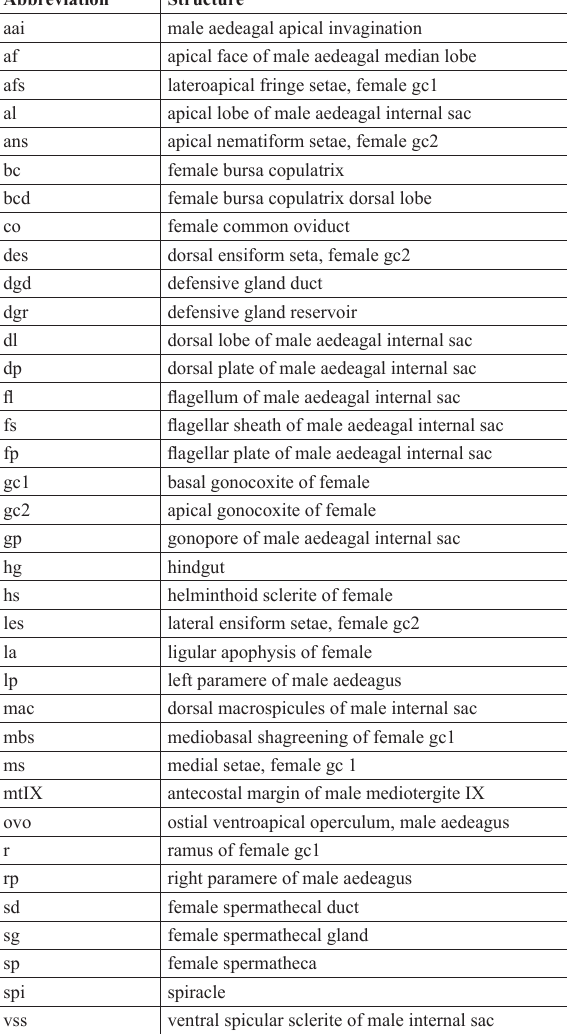
Table 2. Key to abbreviations for structures of male genitalia, and female genitalia and reproductive